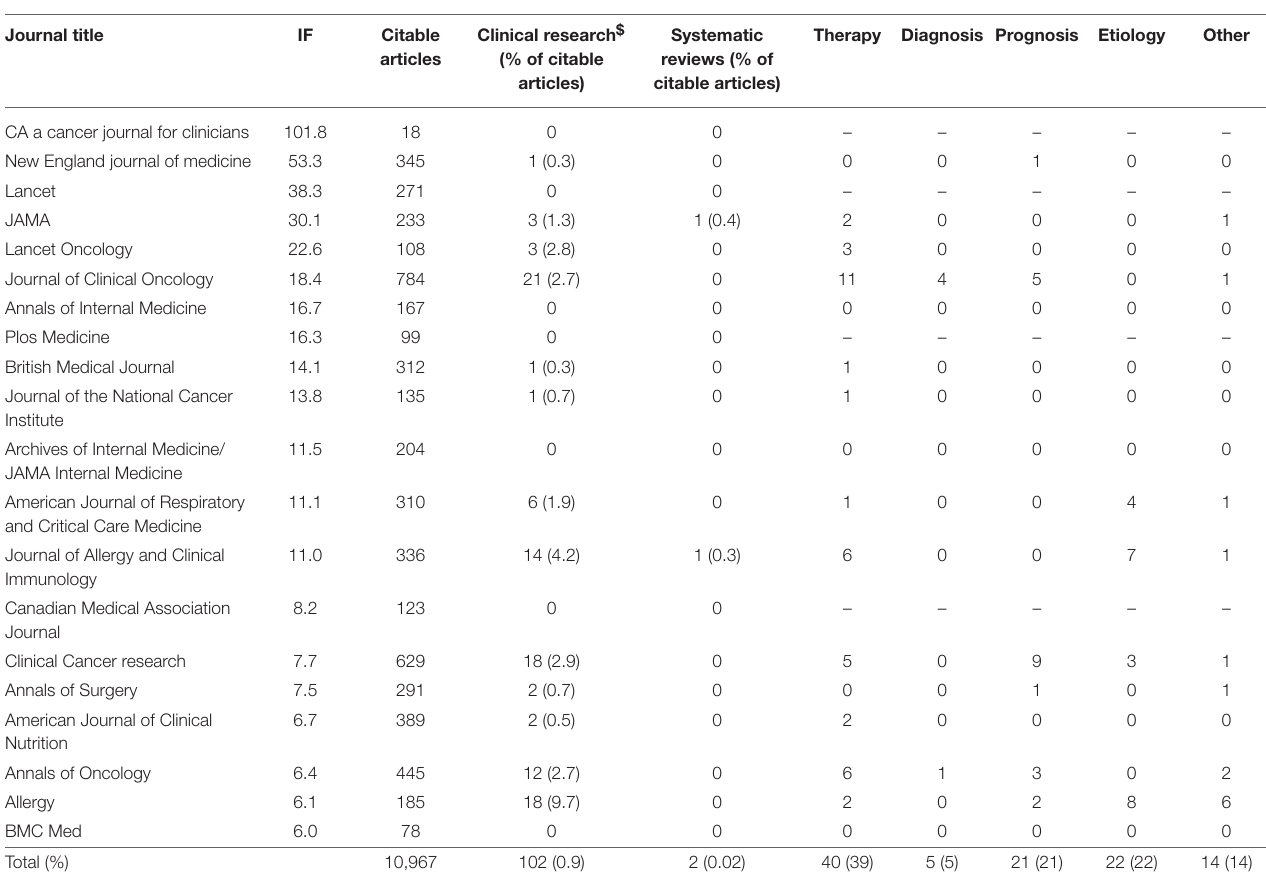
TABLE 3.2 | Results 2. Type of research in selected medical